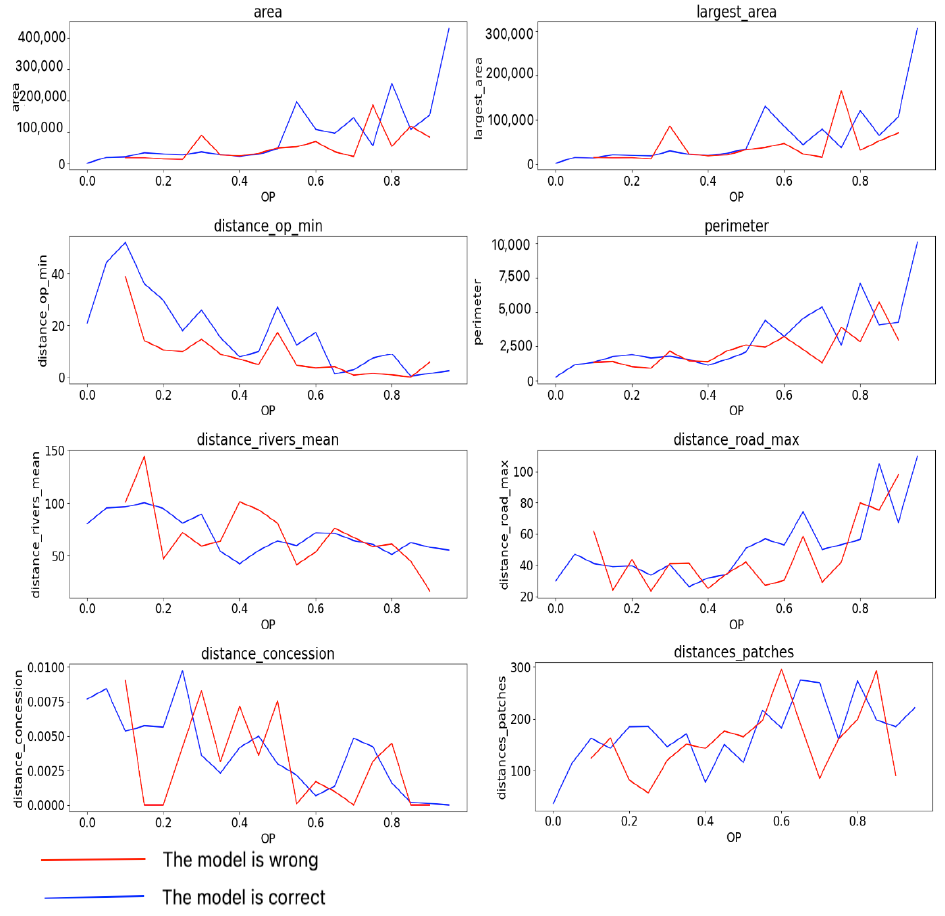
Figure 11. Average values of features versus the probability of being labeled as oil palm.